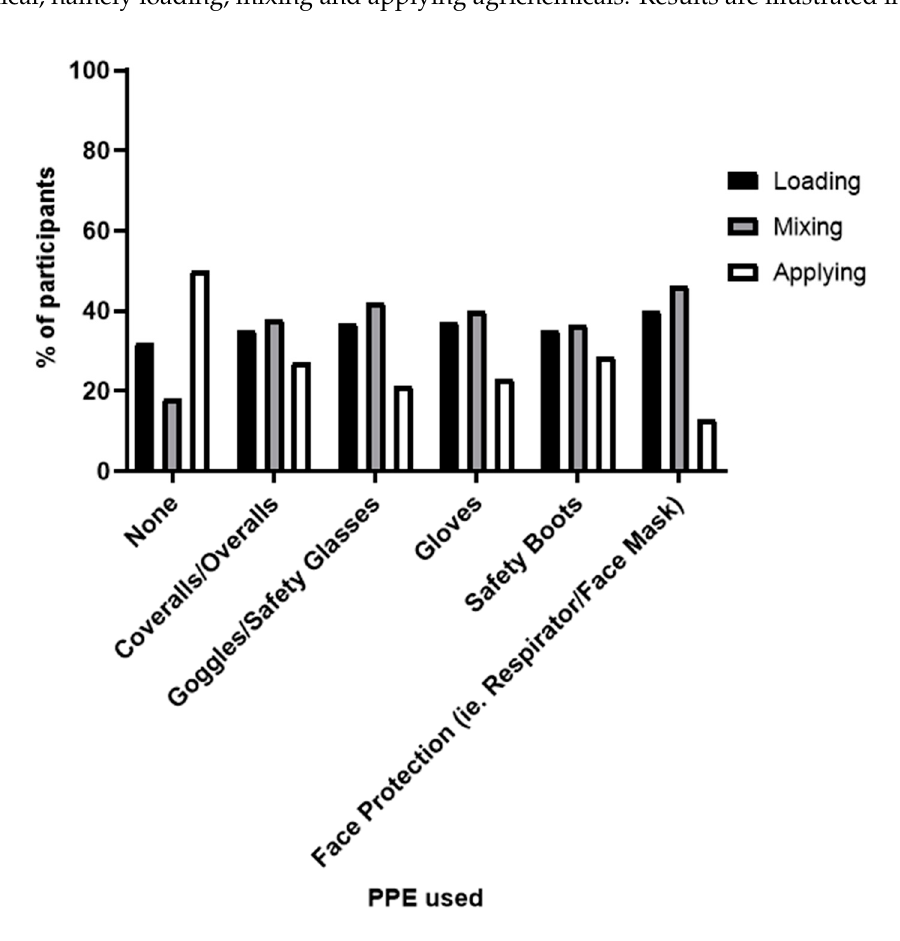
Table 4. Spearman’s rank-order correlation (r s ) frequency between simultaneous use of PPE.